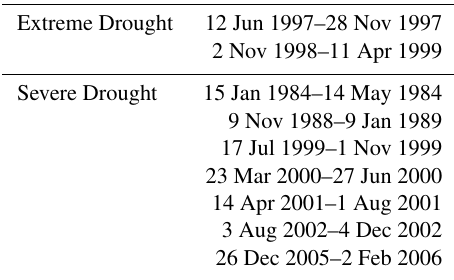
Table 2. Identified severe and extreme drought processes from 1979 to 2008 in northern China.